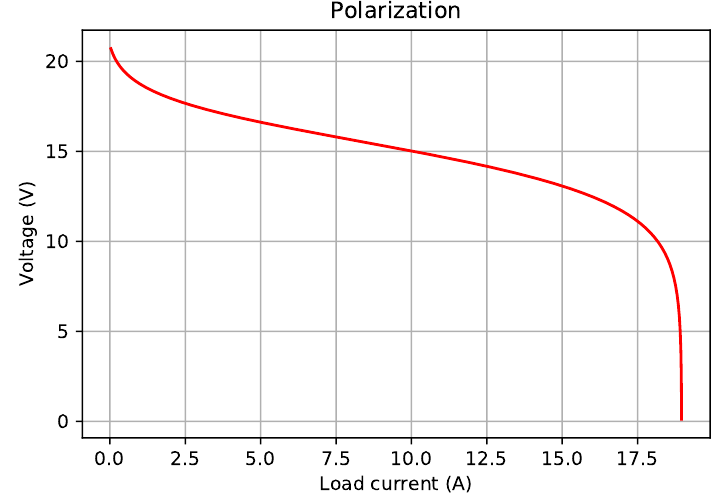
Figure 1. Stack voltage vs. load current plot for the stack given by N s = 22, N p = 1, A cell = 148.443337 cm 2 , and the single-cell parameter values from Table